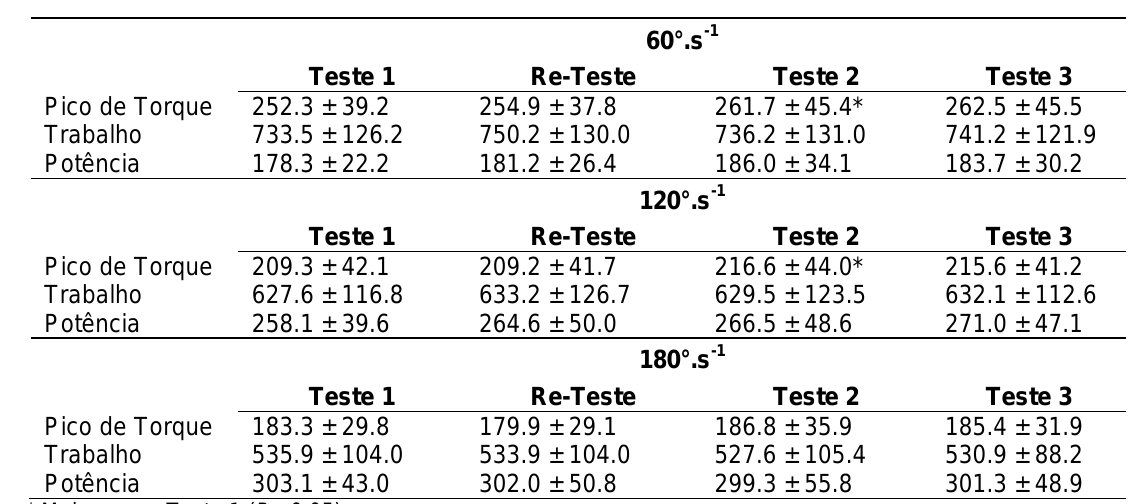
Tabela 1. Valores (média e desvio-padrão) do pico de torque (N.m), trabalho total ( J) e potência (W), durante cada teste realizado nas velocidades de 60°.s -1 , 120°.s -1 e 180°.s -1 .